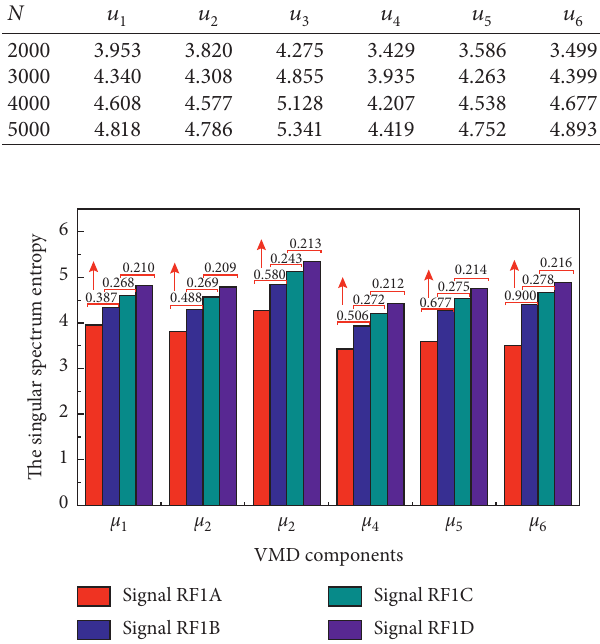
Figure 6: Singular spectrum entropy histogram of the four